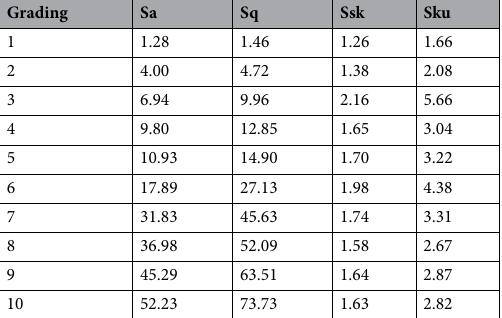
Table 2. Characteristics of different grades of cultivated